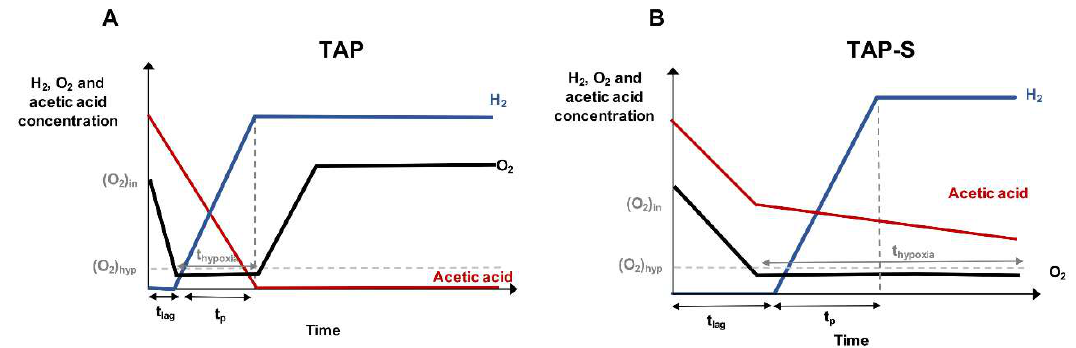
Figure 3. Typical trends of H 2 , O 2 and acetic acid concentrations of Chlamydomonas cultures incubated in TAP ( A ) and TAP-S ( B ). In TAP cultures ( A ), H 2 production occurs only in the presence of acetic acid, which is necessary to establish hypoxic conditions. In TAP-S cultures ( B ), the H 2 production phase and the hypoxic phase are independent of the acetic acid concentration. Under the same light conditions, TAP cultures show faster acetic acid uptake and shorter lag phase than in TAP-S. H 2 production yield and duration in TAP-S cultures is often higher than in TAP cultures. T lag , lag phase before H 2 production; t p , H 2 production phase; t hypoxia , hypoxia / anaerobic phase; (O 2 ) in , initial O 2 levels; (O 2 ) hyp , minimal O 2 levels compatible with H 2 production.